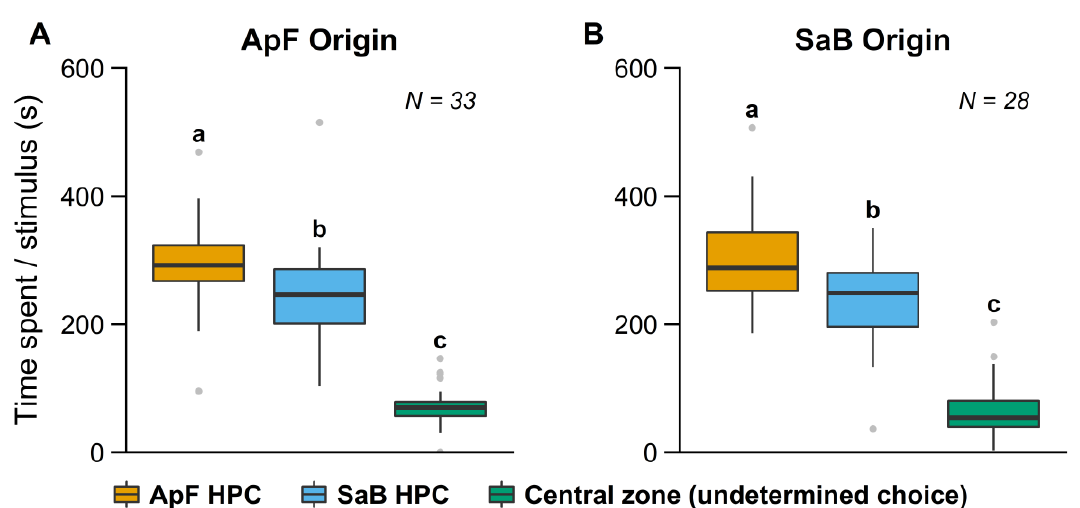
Figure 4. Time spent in the different branches of the olfactometer by A. ervi females reared in complex environments. Females were reared for several generations ( A ) on the A. pisum /faba bean HPC (ApF) or ( B ) on the S. avenae /barley HPC (SaB). Boxplot boundaries indicate the first and third quartiles and black lines within plots indicate the median for each treatment. Whiskers length equal to 1.5× interquartile range, other points are outliers. Bars with the same lower-case letters indicate no significant differences (Wilcoxon test).